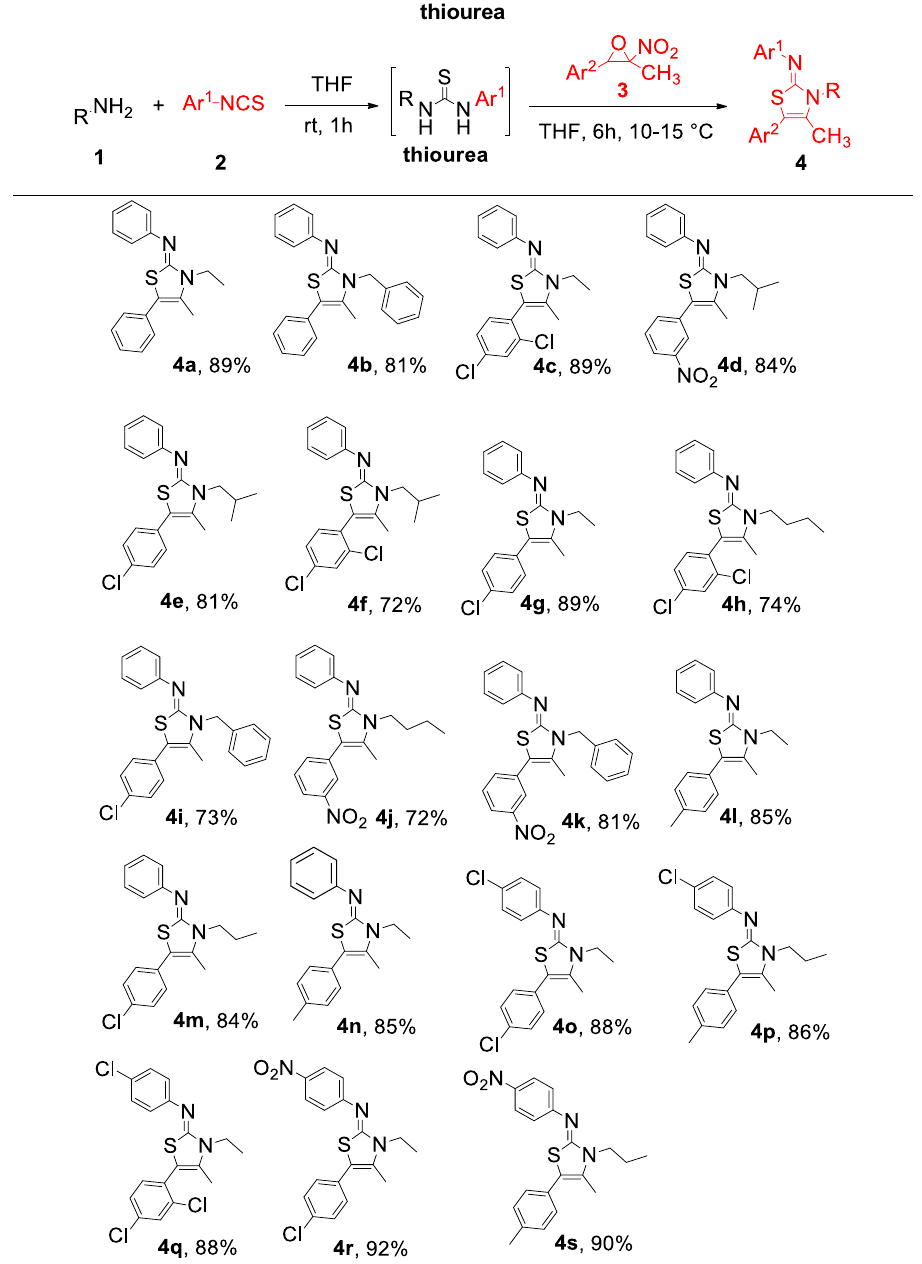
Table 2. Diversity in the synthesis of 2-iminothiazoles a,b . a Reaction conditions: amine (1.2 equiv)